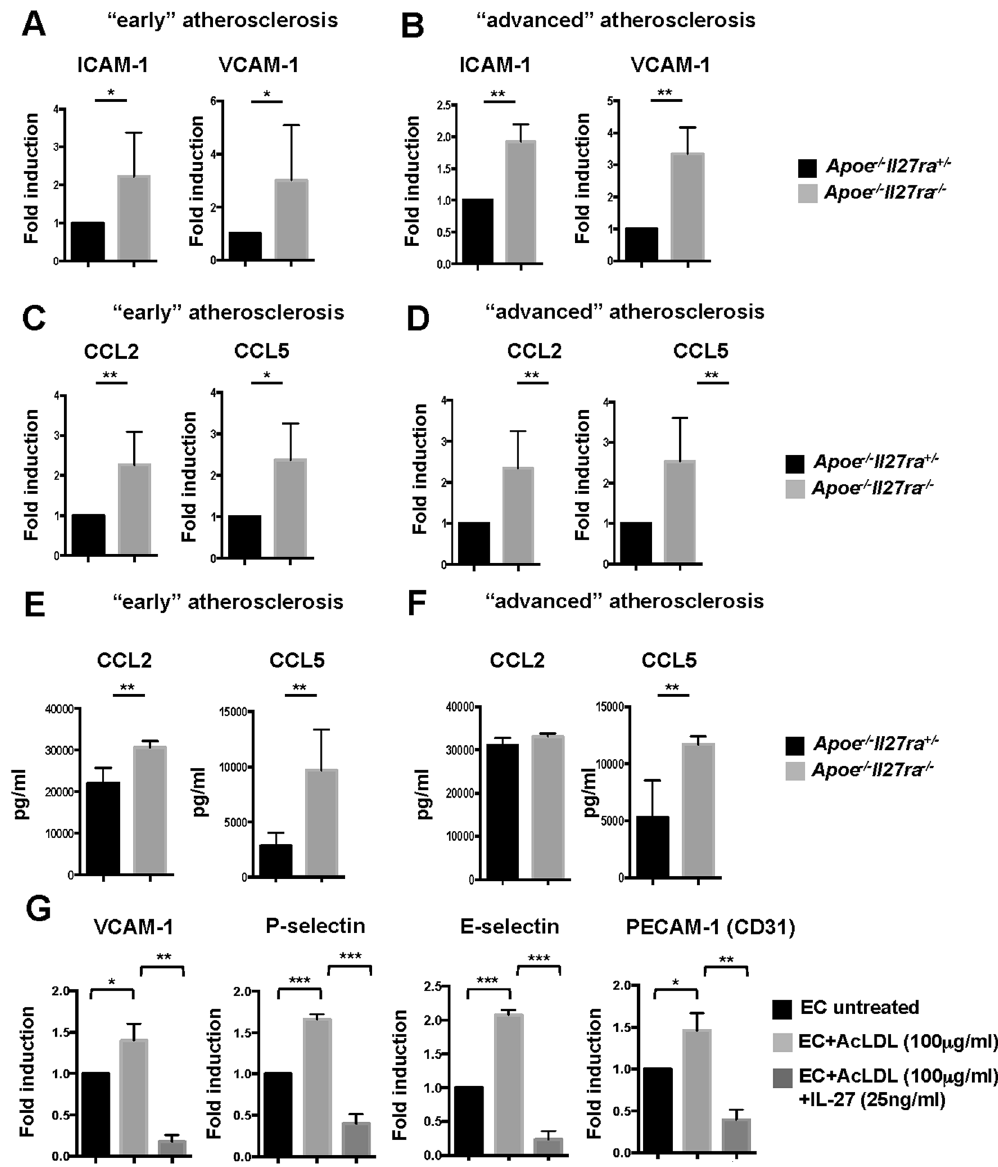
Figure 2. Upregulated expression of chemokines and adhesion molecules in aortas of Apoe − / − Il27ra − / − mice. ( A , B ) Relative gene expression of adhesion molecules ICAM-1 and VCAM-1 in aortas of Apoe − / − Il27ra − / − (n = 5) mice fed with WD for 7 weeks ( A ) or 18 weeks ( B ) were normalized to L-32 and fold induction was calculated based on the gene expression in aortas of control Apoe − / − Il27ra + / − (n = 5) mice. ( C , D ) Relative gene expression of CCL2 and CCL5 in aortas of Apoe − / − Il27ra − / − (n = 5) mice fed with WD for 7 weeks ( C ) or 18 weeks ( D ) were normalized to L-32 gene expression and fold induction was calculated based on the gene expression in aortas of control Apoe − / − Il27ra + / − (n = 5) mice. ( E , F ) CCL2 and CCL5 were measured by multiplex cytokines array in supernatants obtained from aortic cell suspensions of Apoe − / − Il27ra + / − (n = 5) or Apoe − / − Il27ra − / − (n = 5) mice fed with WD for 7 weeks ( E ) or 18 weeks ( F ) stimulated with anti-CD3/ anti-CD28 for 48 hours. ( G ) Relative gene expression of vascular adhesion molecule VCAM-1, P-selectin, E-selectin and PECAM-1 in endothelial cells (mLEC cell line) treated with acLDL (100 μ g/ml) and rIL-27 (25ng/ml) were normalized to L-32 and fold induction was calculated based on the gene expression in untreated endothelial cells. Data are mean ± SEM from at least 2 independent